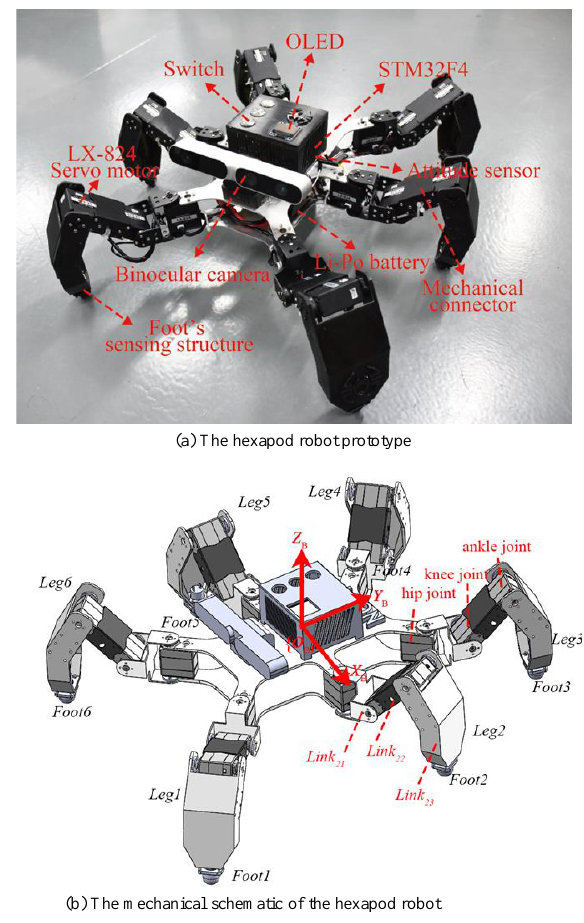
Figure 1. The hexapod